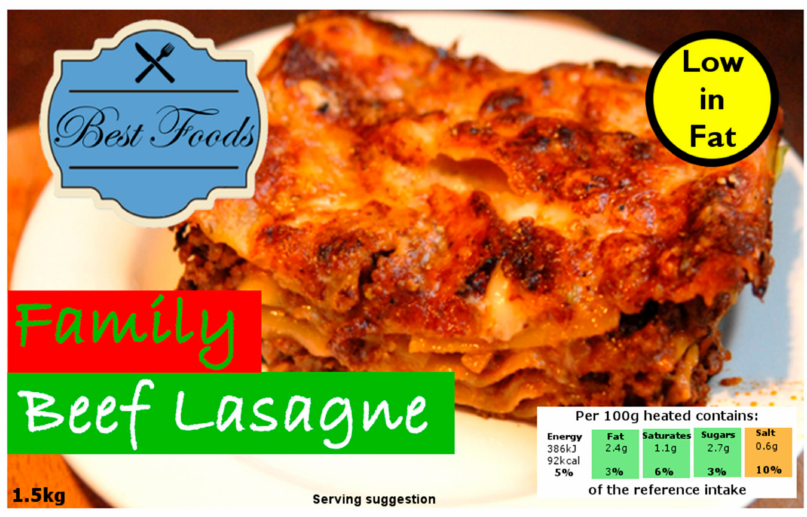
Figure 1. Example of food packaging with claims used in survey. Lasagne photograph from Leon Wilson (https://www.flickr.com/photos/chop/973369384)—CC BY 2.0 (https://creativecommons. org/licenses/by/2.0/). Modified to include labels and